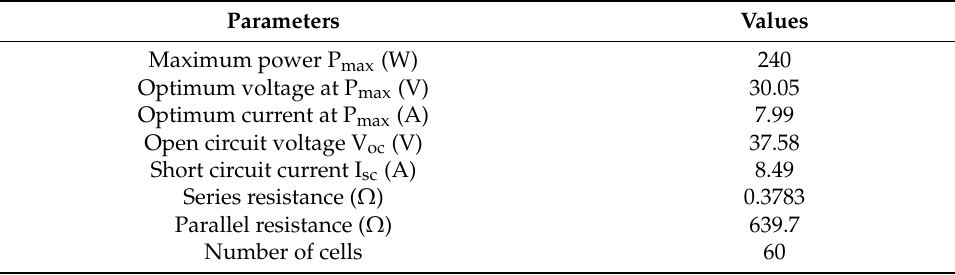
Figure 3. P-V curve of SOLARIA S6M2G240 module under different irradiance. Table 1 lists the parameters of the chosen PV panel at the STC. Table 1. SOLARIA S6M2G240 module parameters.